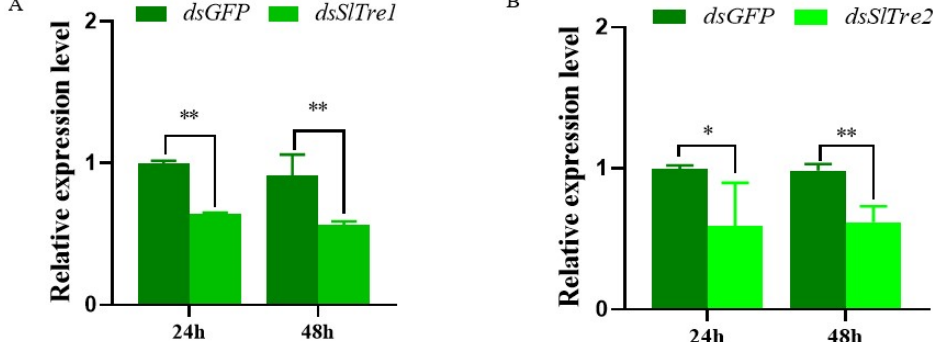
Figure 4. Expression levels of SlTre1 ( A ) and SlTre2 ( B ) after dsSlTres injection in parasitized third instar S. litura larvae. Significant differences in the expression levels of each target gene were compared using ANOVA. Significant differences are indicated by asterisks (* p < 0.05; ** p < 0.01, Table S4).